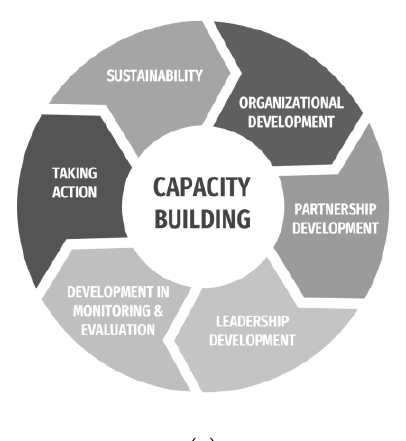
Figure 1. ( a ) Capacity building model adapted from Centre for Innovative Education Solutions (CIES). ( b ) Outline of the four IRs.